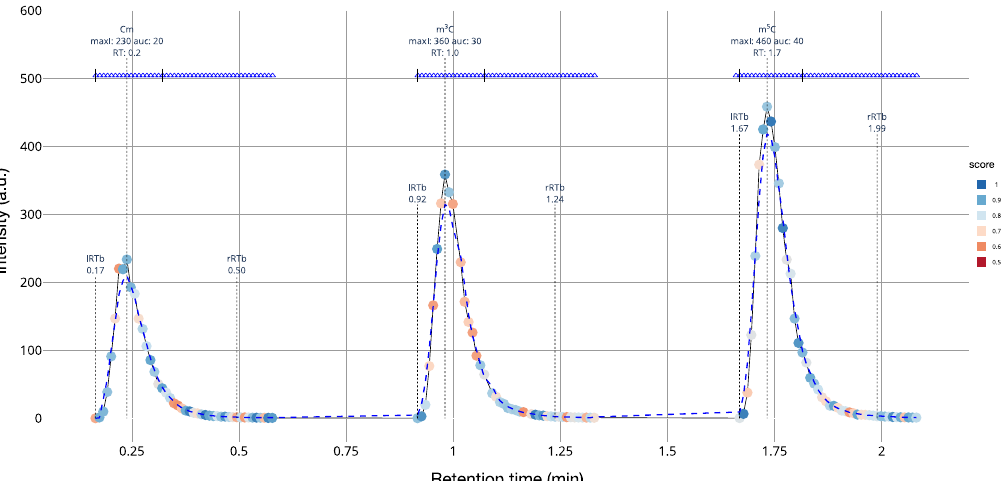
Figure 2. Extracted ion chromatograms from a simulated liquid-chromatography-coupled tandem mass spectrometry (LC-MS/MS) run containing the modified cytidines: 2 ′ - O -methylcytidine (Cm), 3-methylcytidine (m 3 C), and 5-methylcytidine (m 5 C) analyzed and visualized by MORAST. The color of the dots represents the matching accuracy of the isotope envelopes, with a score of 1 indicating a perfect match (dark blue), and a score of 0.5 indicating a weak match (dark red). Color gradient was set up using ColorBrewer (colorbrewer2.org: accessed on 10 March 2021). Blue triangles at the top mark spectra, for which the molecule was identified in the corresponding MS2 spectrum.